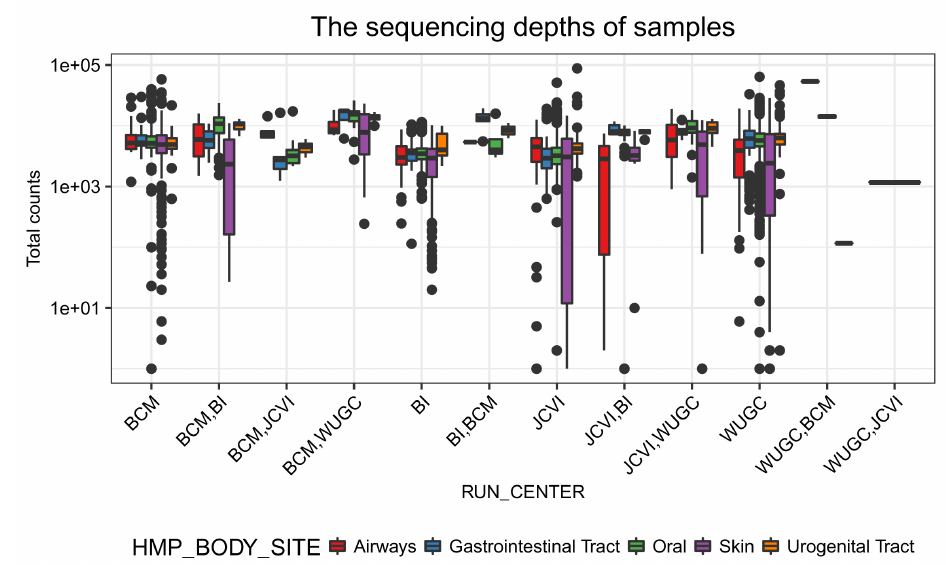
Figure 7. The sequencing depth of samples from different research centers. Samples collected at different body sites are in different colors.